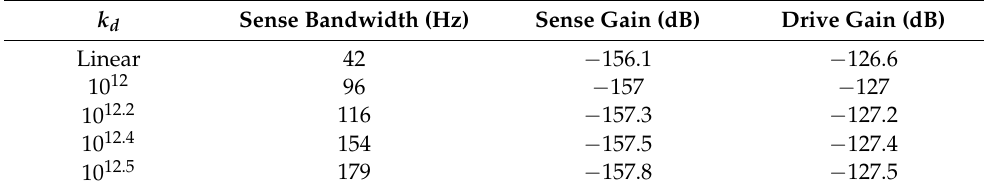
Figure 8. Comparison of the different nonlinear coefficients k d : ( a ) drive mode; ( b ) sense mode. Table 4. Effect of the nonlinear coeffients k d on gain and bandwidth.